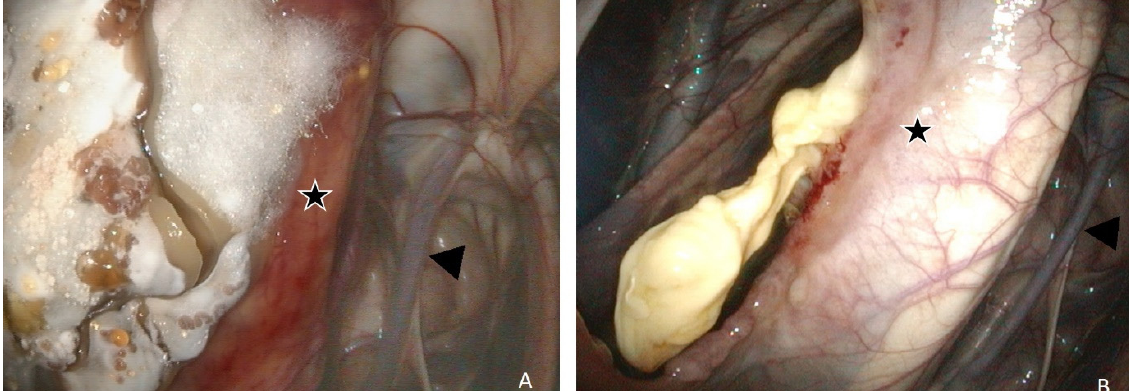
Figure 4. Endoscopic evaluation of Horse 2. Left GP (guttural pouch) presented with bilateral mycosis and treated only with TOT (topical oxygen therapy): ( A ) at admission, a thick granulomatous plaque covered with white brilliant mycelia is located on the median septum (star); ( B ) after 27 days’ of TOT, the absence of mycotic lesions with the exception of a small amount of necrotic tissue in the scarring of a large septum fistula. Arrowhead, left ICA (internal carotid artery).